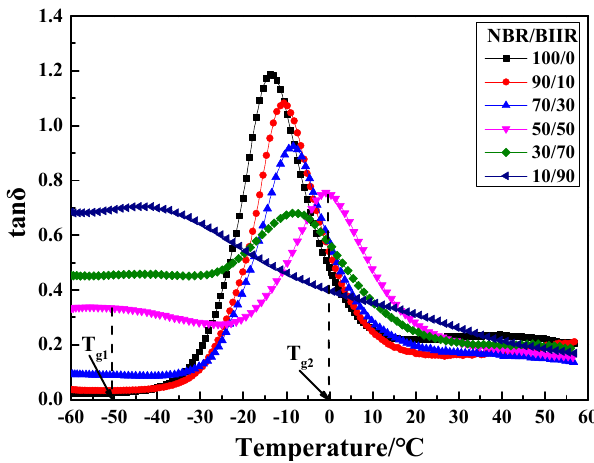
Figure 11 . Damping properties versus temperature for NBR/BIIR with various blend ratios. Figure 11. Damping properties versus temperature for NBR / BIIR with various blend ratios.